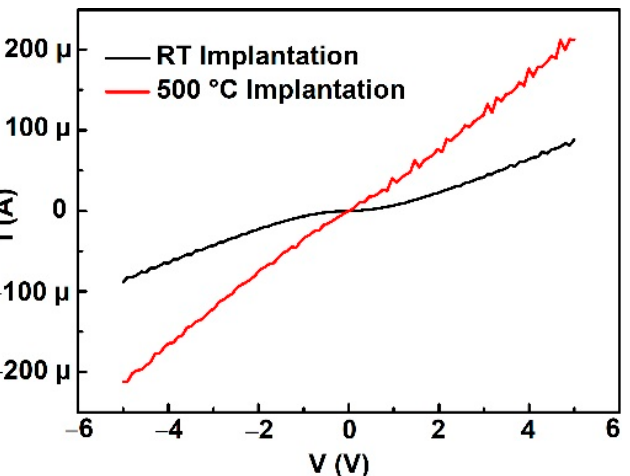
Figure 10. IV characteristics of TLM pattern structure on RT implantation sample and 500 °C implantation sample.